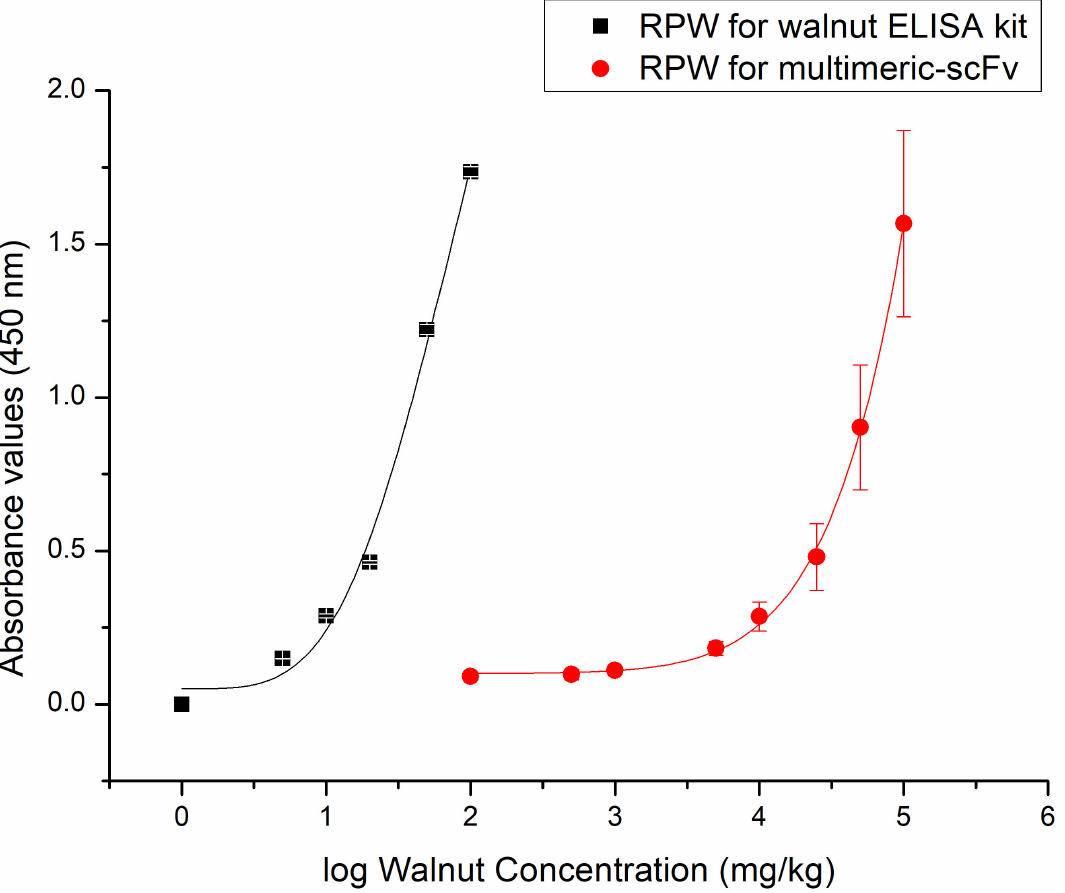
Figure 2. Standard curves obtained from experimental binary mixtures (raw peeled walnut samples in corn flour), analyzed with the Alertox ® walnut ELISA kit ( (cid:4) ) and the multimeric scFv ELISA ( • ). Protein extracts were prepared according to directions of each method and diluted 1:25 (ELISA kit) or 1:100 (scFv ELISA) in PBS for comparison. Points represent the mean value ± SD ( n = 2; 3 independent